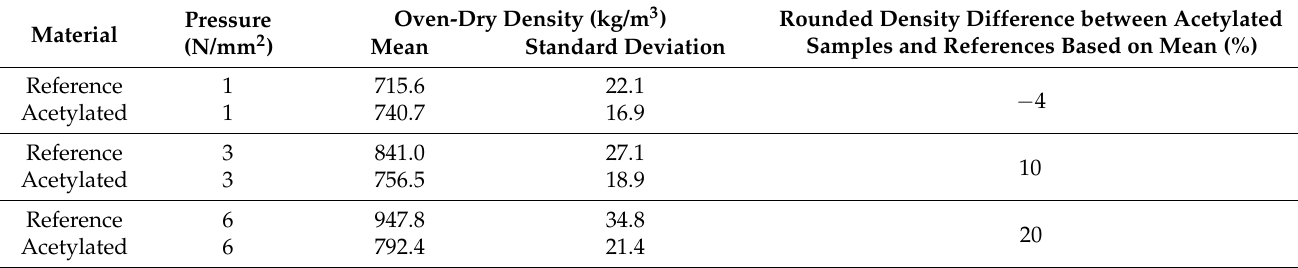
Table 1. Oven-dry density measured with 24 samples on each